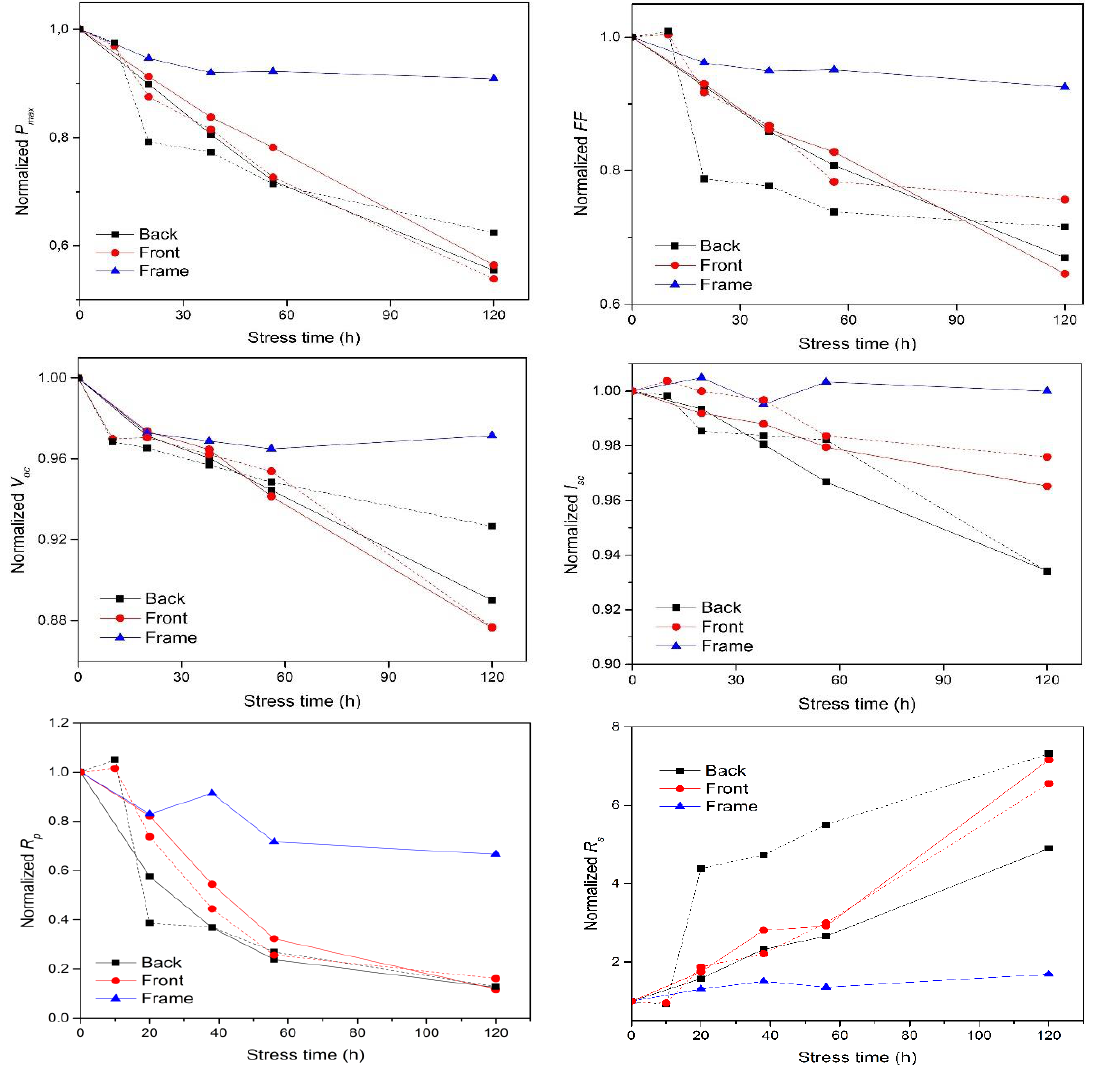
Figure 8. Parameters of the modules with different contacts as a function of time. The dotted lines refer to the light soaked modules.